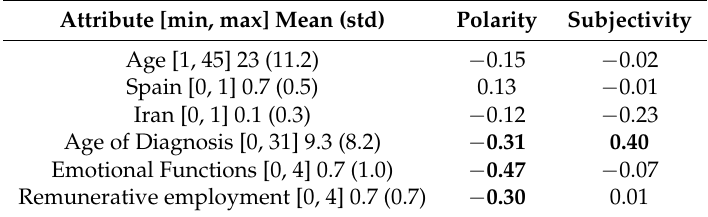
Table 3. Correlations between some numerical attributes and polarity and subjectivity of the